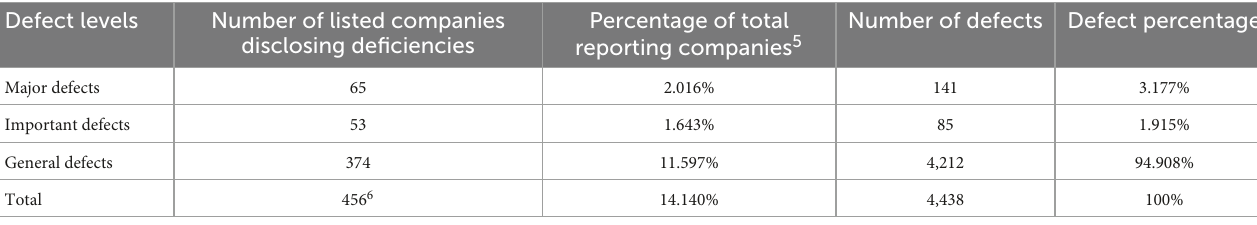
TABLE 1 Analysis of the status of disclosure of internal control deficiencies in listed